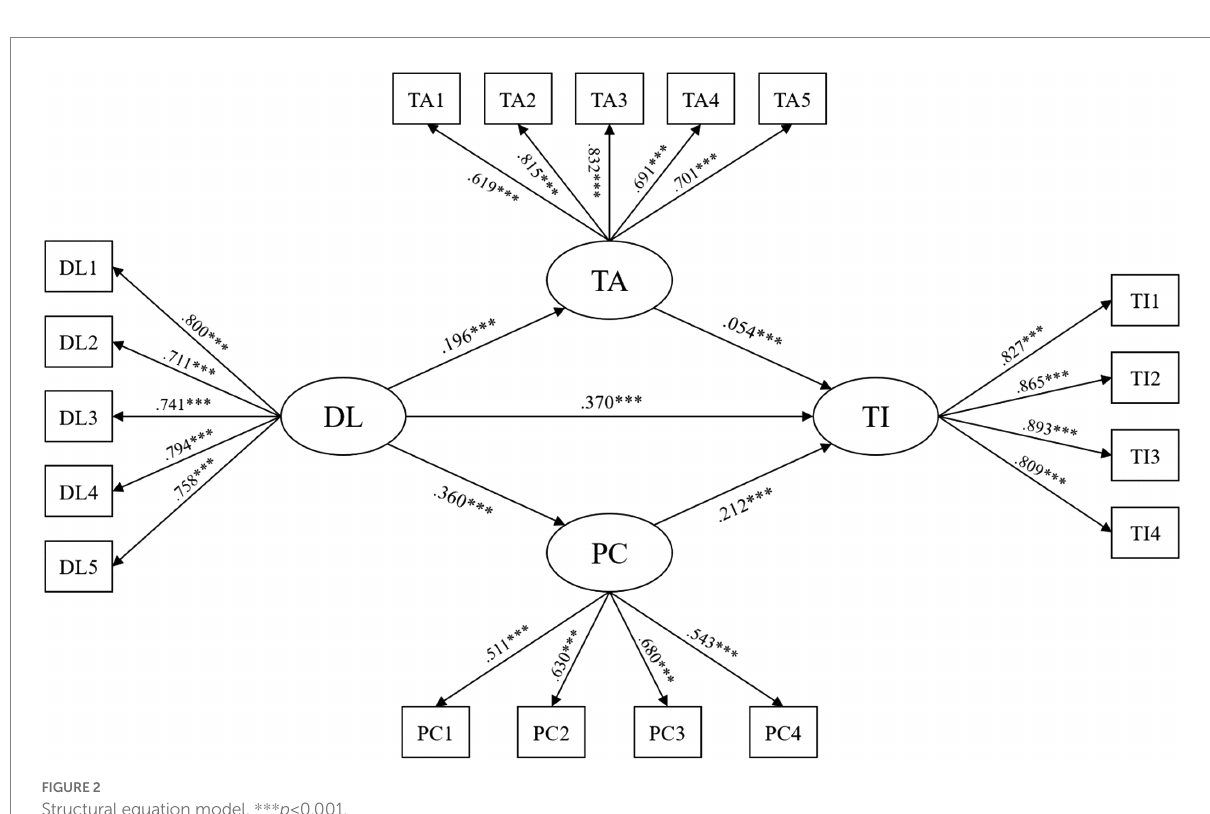
FIGURE 2 Structural equation model. *** p <